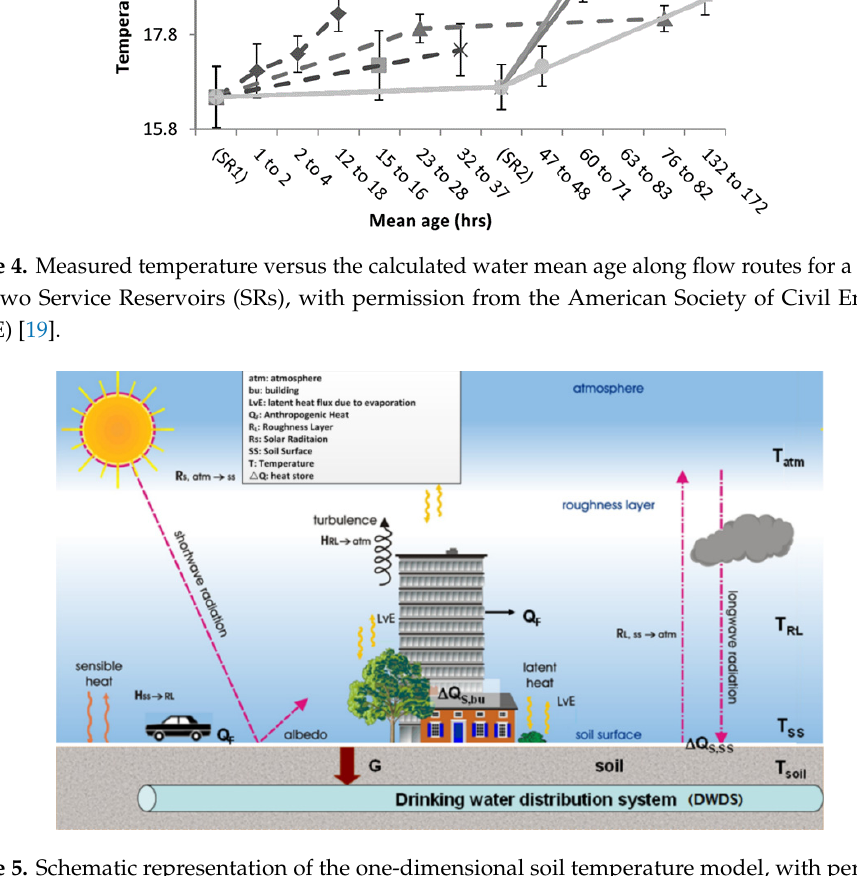
Figure 5. Schematic representation of the one-dimensional soil temperature model, with permission from Copernicus Publications [21].